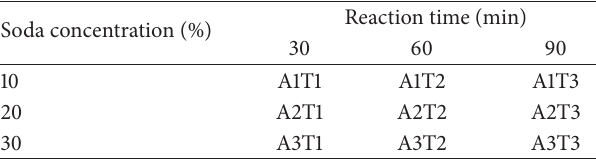
Table 1: Mercerization conditions: